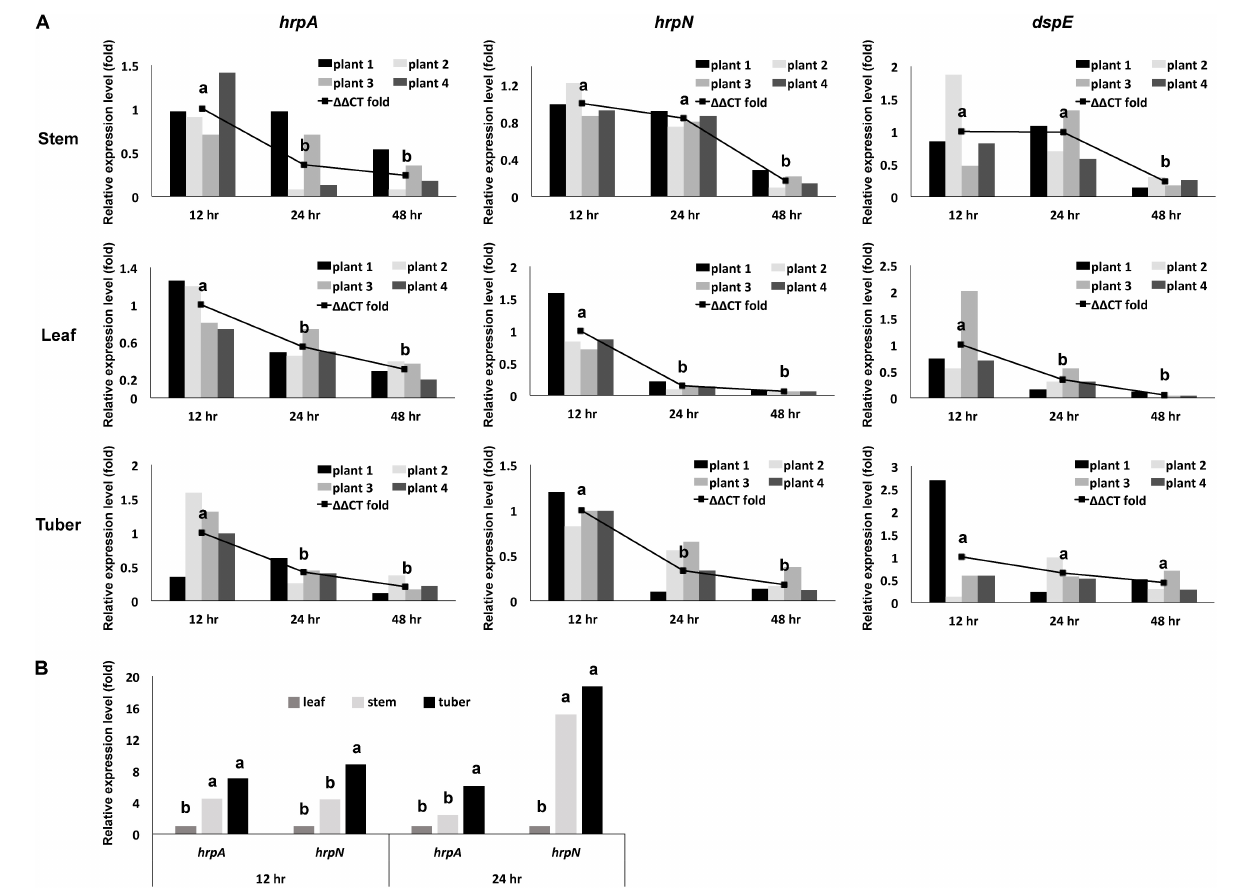
FIGURE 2 | Overall expression of representing T3SS genes in a D. dadantii population, as defined by their mRNA level measured by qRT-PCR, at different stages of infection in different potato organs. (A) mRNA levels of hrpA , hrpN , and dspE in D. dadantii in potato stem, leaf, and tuber at different infection stages. (B) Comparison of mRNA levels of hrpA and hrpN between different organ types at 12 and 24 h post-incubation. Different potato organs were inoculated with wild type D. dadantii . Symptomatic samples were collected at 12, 24, and 48 h post-inoculation for RNA isolation. The abundance of hrpA , hrpN , dspE , and rplU mRNA was measured by qRT-PCR. Relative expression of hrpA , hrpN , and dspE to the endogenous control rplU was calculated by the (cid:49)(cid:49) Ct method. The relative expression of each of the four biological replicates, as calculated by 2 − (cid:49) Ct , is also displayed. Statistic analysis was performed using the one-way analysis of variance (ANOVA) model in the “stats” package in R. The presence of different letters indicates significant difference at P <